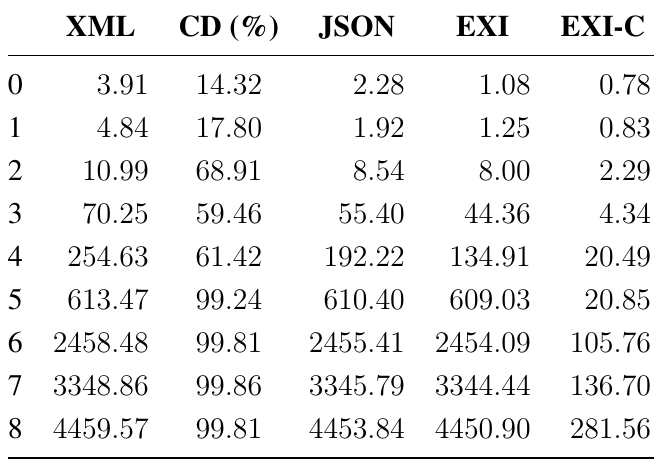
Table 3. Size of files (KBs) for each format and content density of the original XML files (OBS dataset).